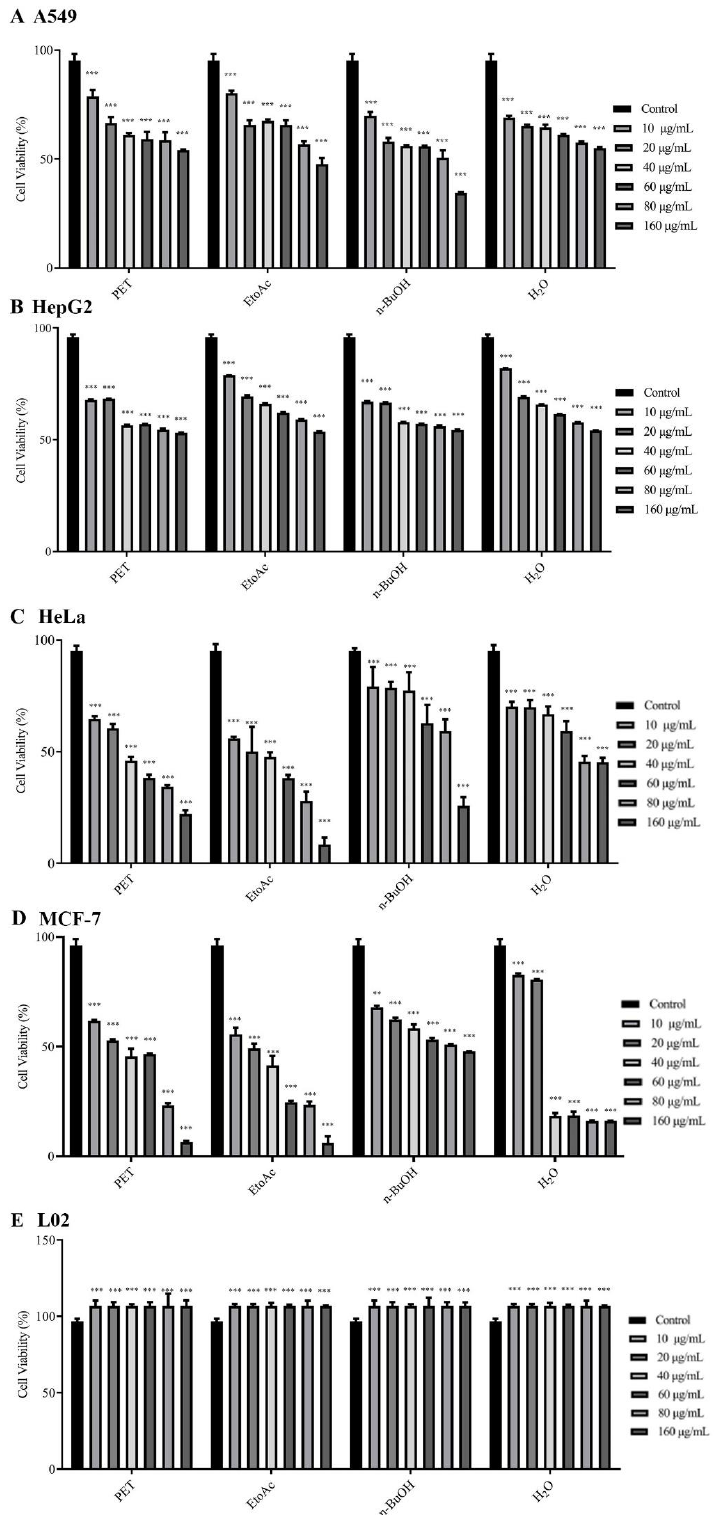
Figure 1. Effects of different fractions (PET, EtoAc, n-BuOH, and H 2 O) on A549, HepG2, HeLa, MCF-7, and L02 cell viability. ( A ) Effects of different fractions on A549 cell viability. ( B ) Effects of different fractions on HepG2 cell viability. ( C ) Effects of different fractions on HeLa cell viability. ( D ) Effects of different fractions on MCF-7 cell viability. ( E ) Effects of different fractions on L02 cell viability. ** p < 0.01, *** p < 0.001 vs. control